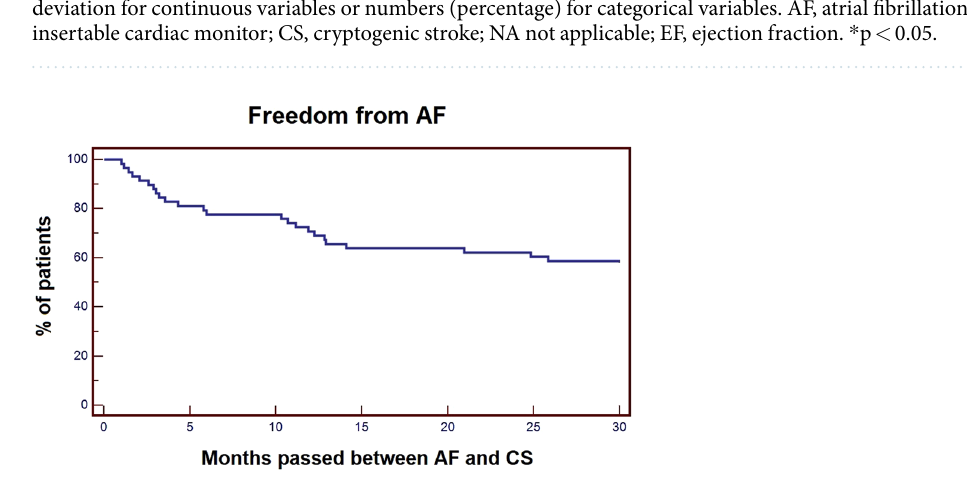
Figure 1. Kaplan-Meier cumulative curve for all patients when the time passed between the occurrence of AF and the CS is used as the survival time variable. AF, atrial fibrillation; CS, cryptogenic